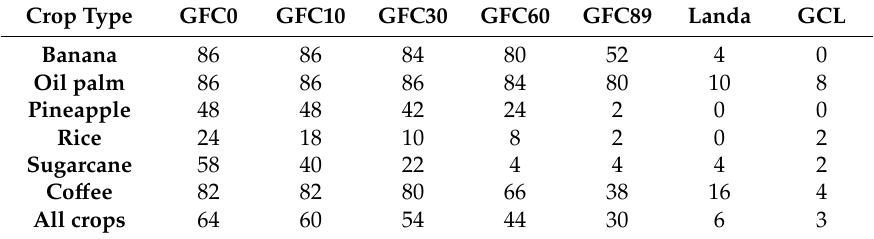
Table 4. Commission error of map products in agricultural areas. The percentage of agricultural validation points with forest cover is shown. Percentages were calculated for individual crops ( n = 50) and all crops ( n = 300). Tree cover for the GFC map was converted to forest / non-forest cover at several thresholds; for example, GFC0 denotes tree cover > 0%, while GFC10 denote tree cover ≥ 10%, and so